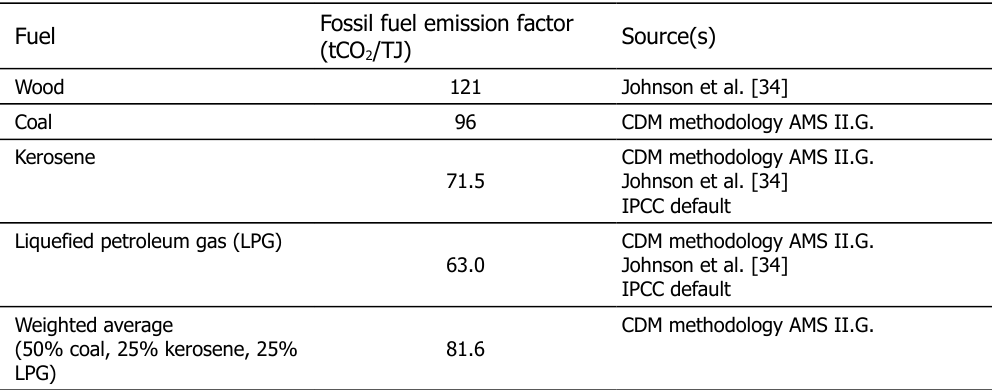
Table 3. Comparison of fuel emission